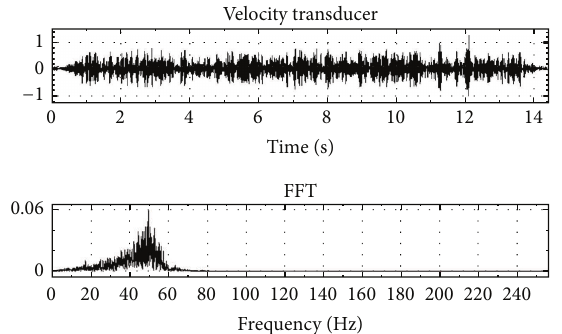
Figure 14: Time domain waveform and spectrogram of velocity response signal in working condition 1.